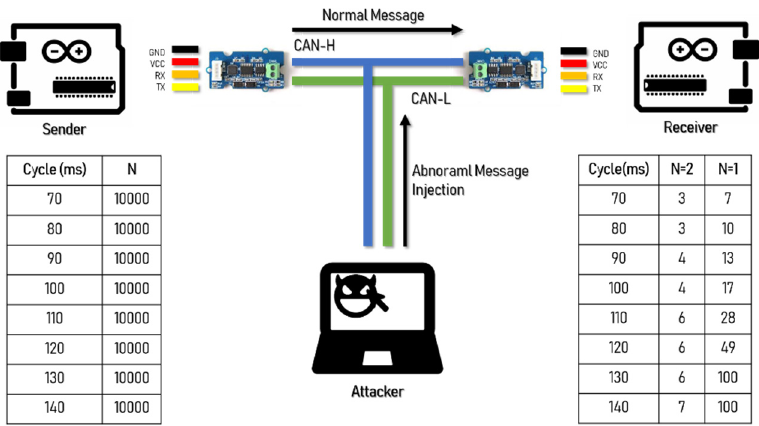
Figure 8. Experiment environment of the transmission rate controller area network (CAN) message. Table 8. Controller area network (CAN) message reception rate.